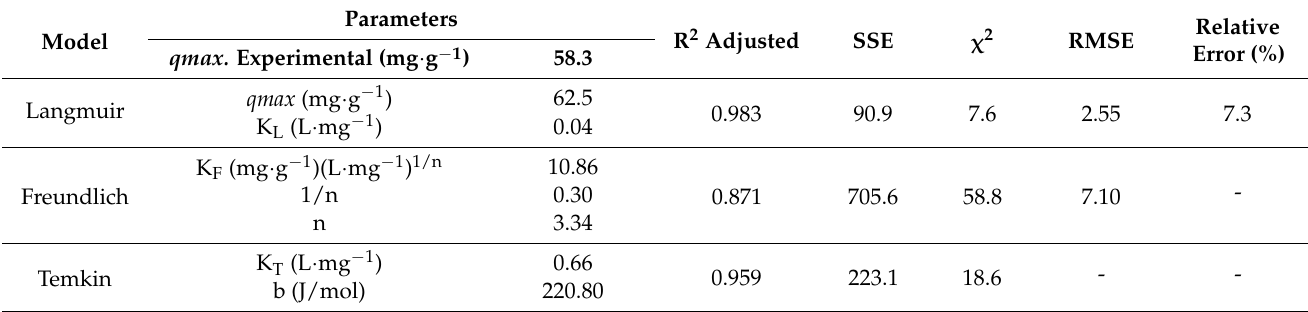
Table 4. Parameters of equilibrium isotherm models applied to the adsorbent NaOH.